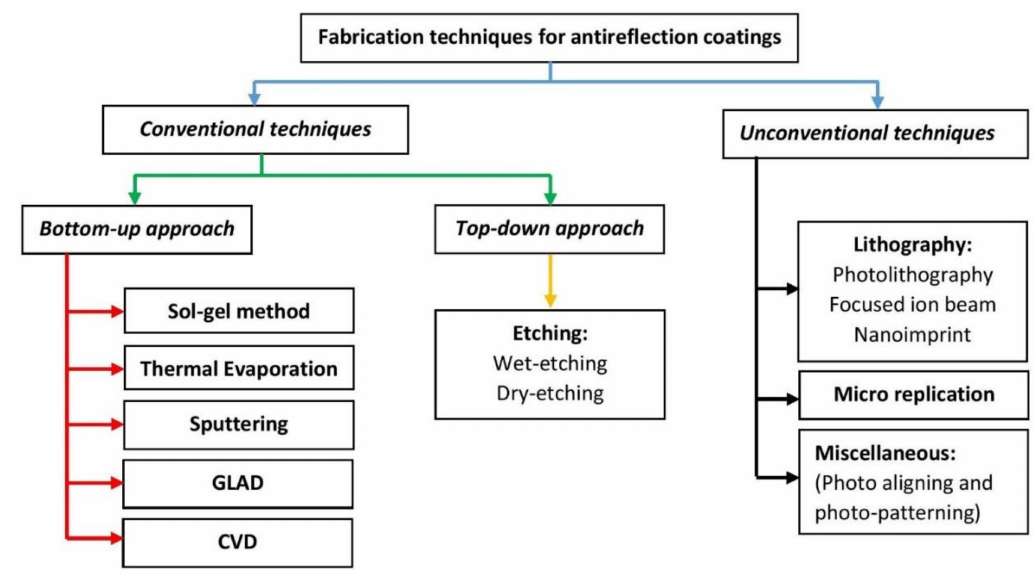
Figure 7. Classification of commonly used fabrication techniques for ARCs.